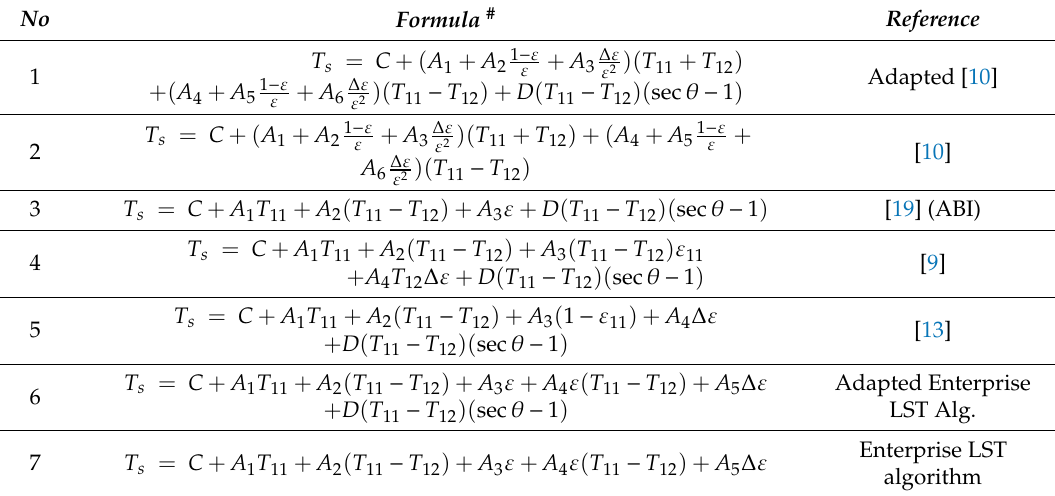
Table 3. Candidate land surface temperature (LST) retrieval